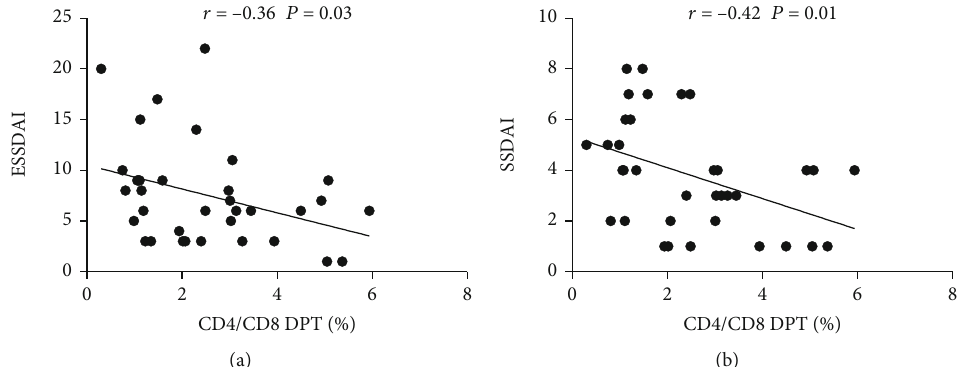
Figure 5: Correlation analysis between the frequency of peripheral DPT cells and ESSDAI, SSDAI (a,